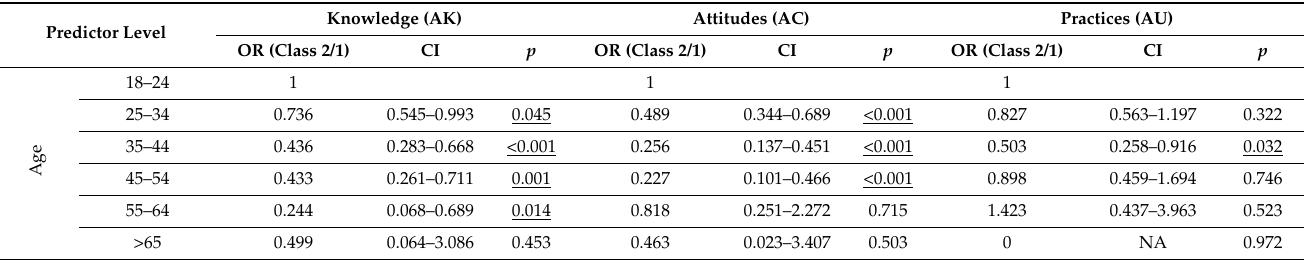
Table 3. Multinomial logistic regression analysis of factors influencing KAPs of antibiotics use and antibiotics resistance among